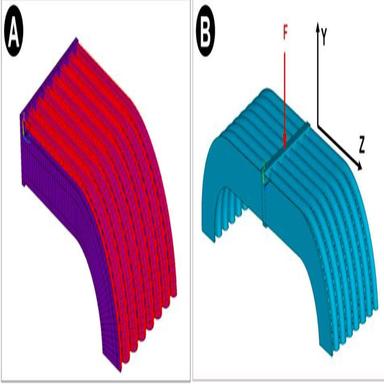
Models of the part of diatom frustule: (A) pressure applied on the upper surface of the structure.